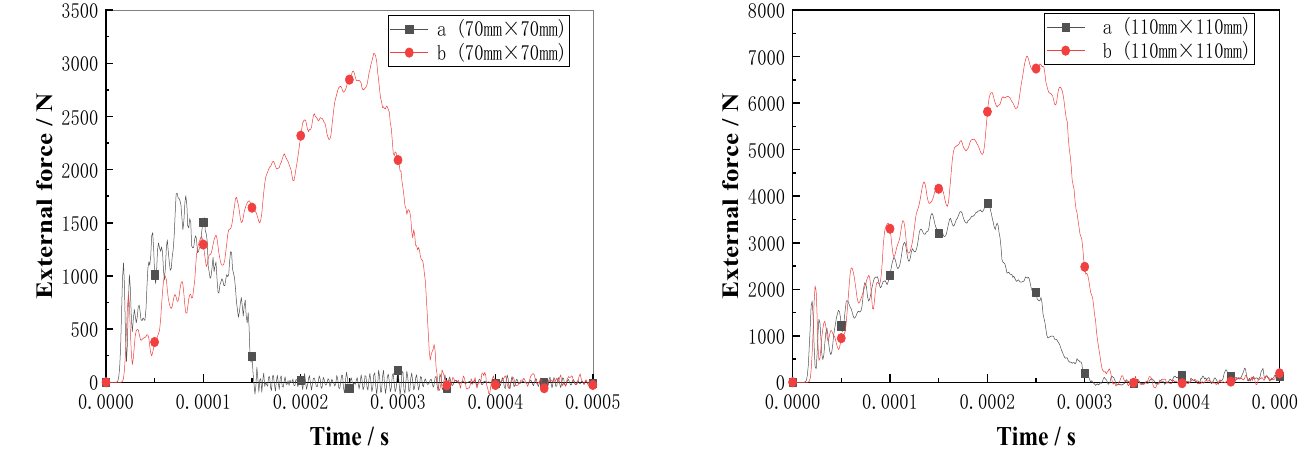
Figure 15. Plots of external force vs. time for the flat compression of the slot resin rib structures.